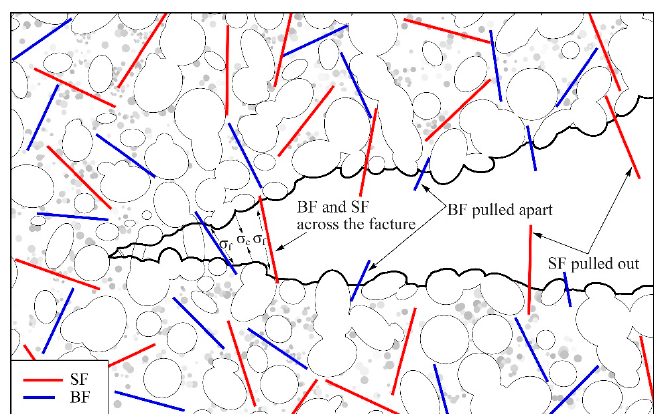
Figure 9. BF and SF distribution in crack area.